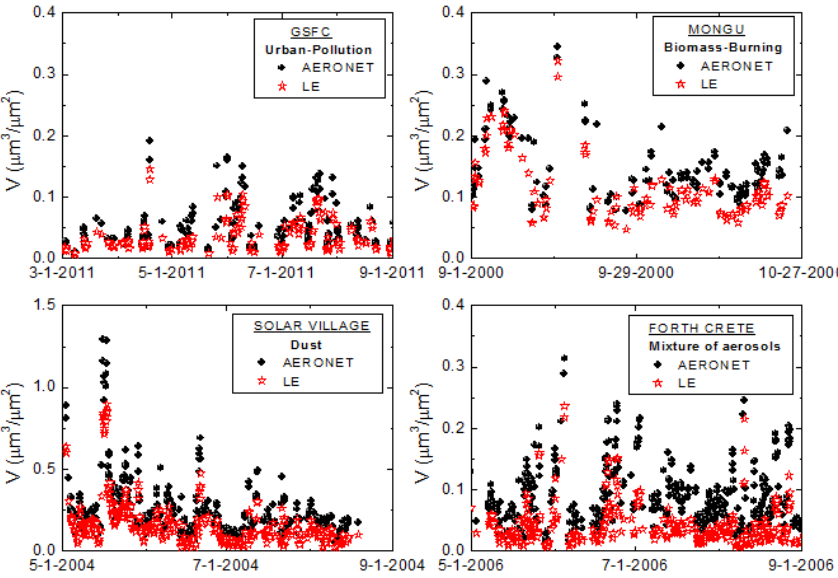
Figure 9. Long-term time evolutions of columnar volume aerosol content ( V ) obtained both by linear estimation (LE) and AERONET retrievals for places with very different aerosol